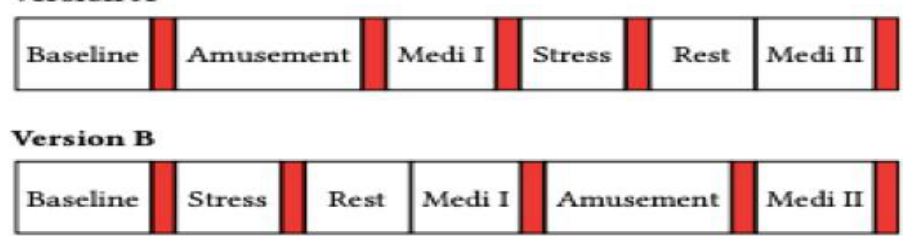
Fig. 2. The two different versions of the study protocol (Adapted from (Schmidt, et al, 2018))